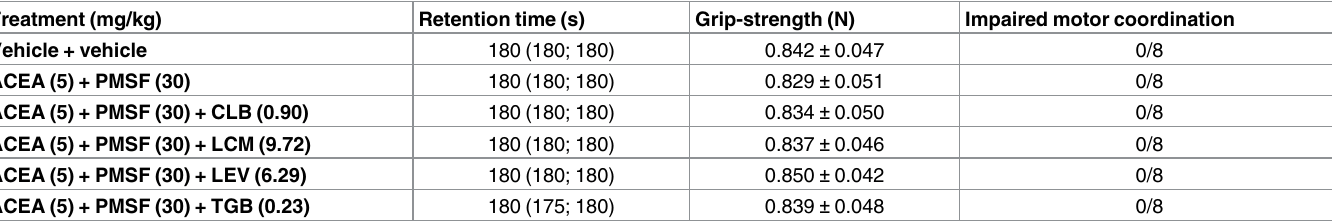
Results are presented as: median retention times (in seconds; with 25 th and 75 th percentiles in parentheses) from the passive avoidance task, assessing acquisition of learning and remembering in mice; mean strengths (in newtons ± S.E.M.) from the grip-strength test, assessing skeletal muscular strength in mice; and number of mice with impaired motor coordinationper total number of the animals in experimental groups challengedwith the chimney test, assessing motor performance in mice. Each experimental group consisted of 8 mice. All drugs were administered i.p. at times scheduled from the 6-Hz corneal stimulation model, and at doses corresponding to the ED 50 value (for more details see Fig